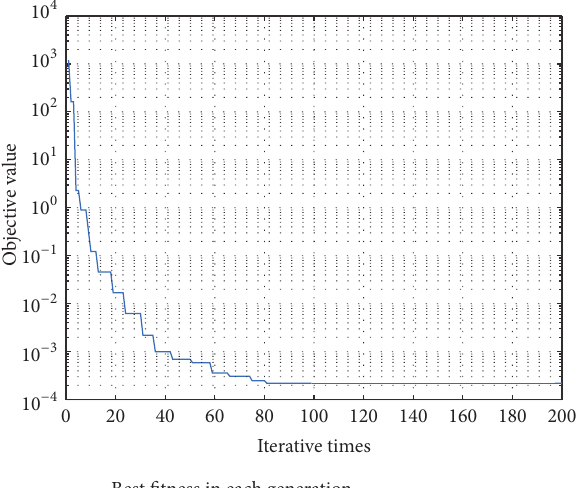
Figure 6: Fitness curve of global optimal points of